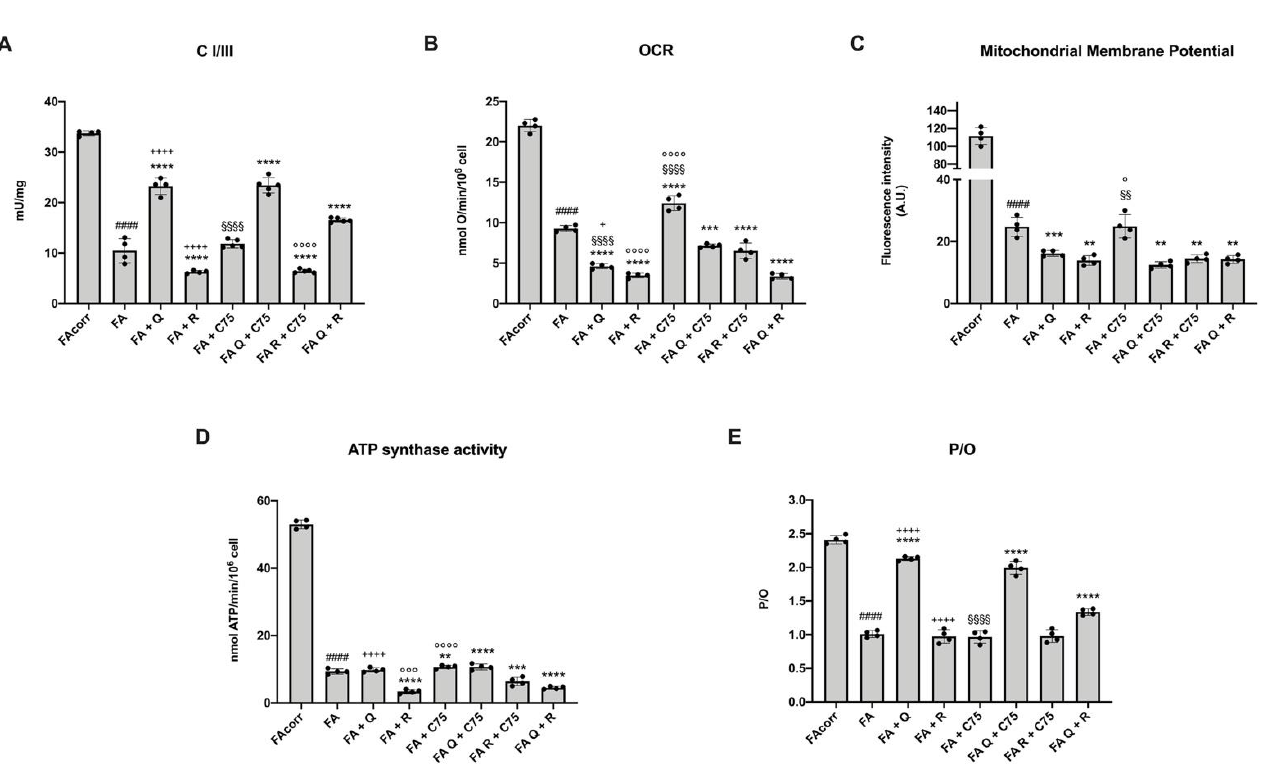
Figure 2. Modulation of aerobic metabolism in FA cells treated with quercetin, rapamycin, and C75, alone or in combination. All data represent experiments conducted after 48 h of drug treatments. ( A ) Electron transport between respiratory Complexes I and III. ( B ) Oxygen consumption rate (OCR). ( C ) Mitochondrial membrane potential measured by cytofluorimetric analysis. ( D ) Aerobic ATP synthesis through F o F 1 -ATP synthase. ( E ) P/O value, calculated as ratio between nmol of synthetized ATP (P) and consumed atomic oxygen (O). This parameter is a marker of OxPhos efficiency. (Q = quercetin alone; R = rapamycin alone; C75 = C75 alone; Q + C75 = quercetin/C75 combination; R + C75 = rapamycin/C75 combination; Q + R = quercetin/rapamycin combination). Each graph represents four independent experiments and data are expressed as mean ± S.D. For FA and FA-corr cells, data are representative of four different Fanc-A lymphoblast cell lines. Statistical analysis was performed via one-way ANOVA followed by Tukey multiple comparison test. #### indicates a p < 0.0001 between FA cells and FA-corr cell lines; **, ***, or **** indicate a p < 0.01, 0.001, or 0.0001, respectively, between untreated and treated FA cells. +, or ++++ indicate a p < 0.05, or 0.0001, respectively, between treatment with quercetin or rapamycin alone and quercetin/rapamycin combination; §§, or §§§§ indicate p < 0.01, or 0.0001 between treatment with quercetin or C75 alone and quercetin/C75 combination; °, °°°, or °°°° indicate a p < 0.05, 0.001, or 0.0001, respectively, between treatment with rapamycin or C75 alone and rapamycin/C75 combination.